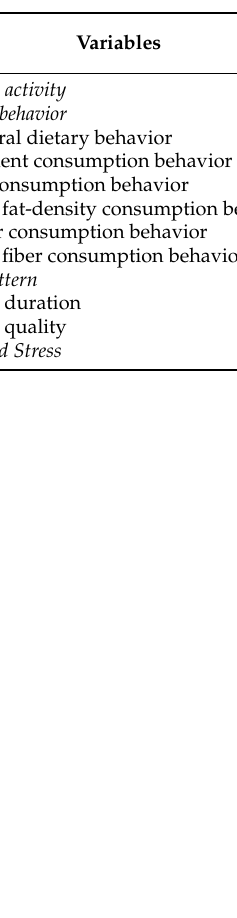
Table 2. Comparison of lifestyle patterns between the different work schedule types.